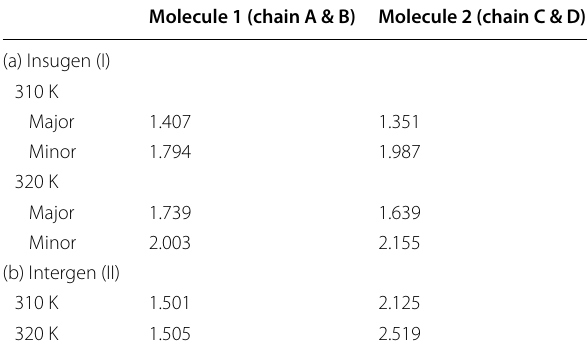
Table 4 RSMD values (Å) for HR insulin structures after the MD simulation